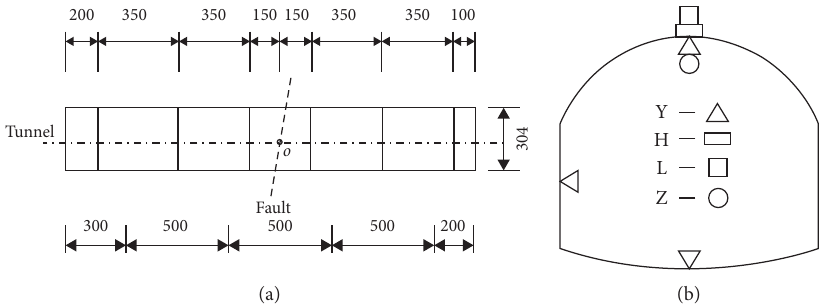
Figure 7: Arrangement of test measurement. (a) Measuring section (unit: mm). (b) Layout of measuring points.